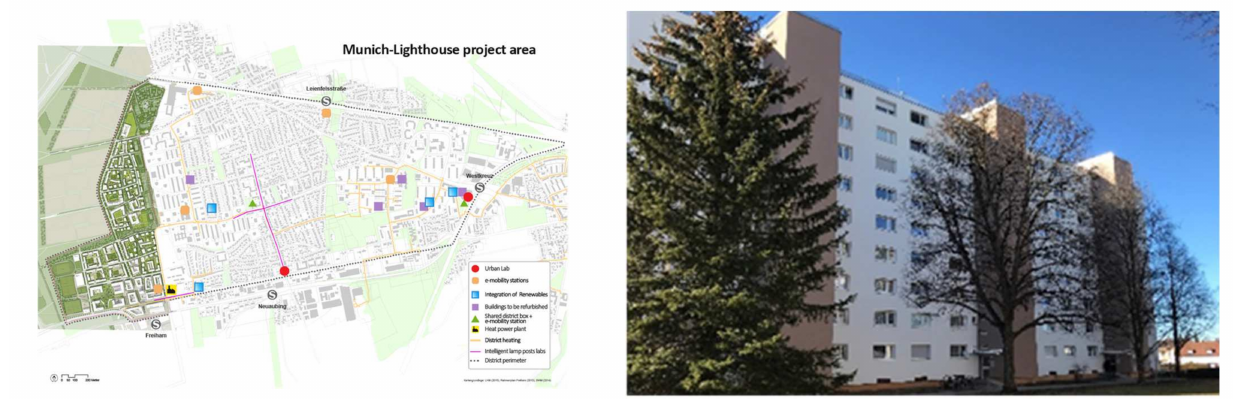
Figure 4. Neuaubing–Westkreuz in Munich ( left ) and Radolfzeller Str. 40–46 building after refurbish- ment ( right ) (Stoppel & Klassen, 2019) [41]. The project area is outlined with a dotted gray line.